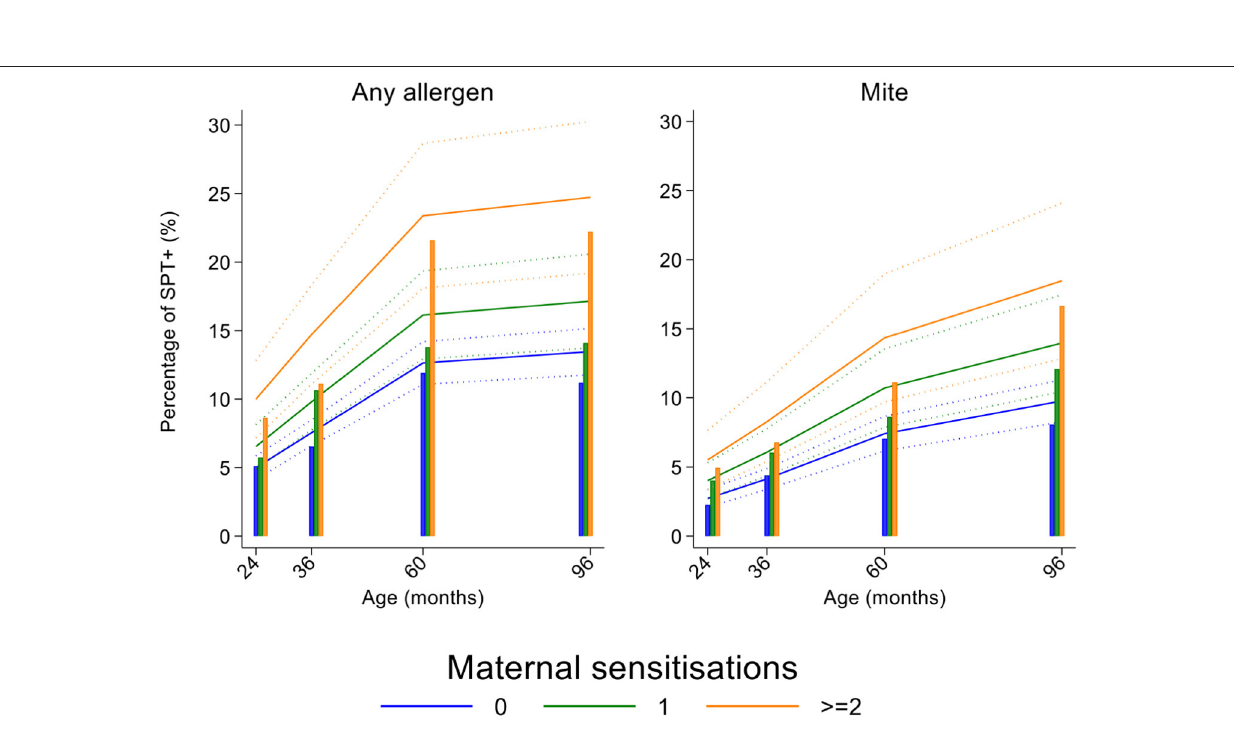
Frontiers in Allergy |